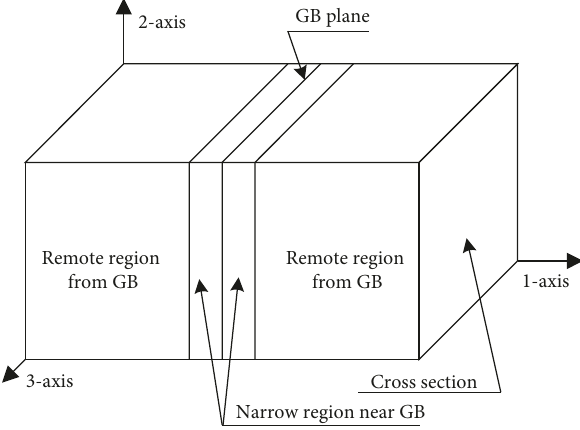
Figure 5: Partitioned model to apply the seed strategy.